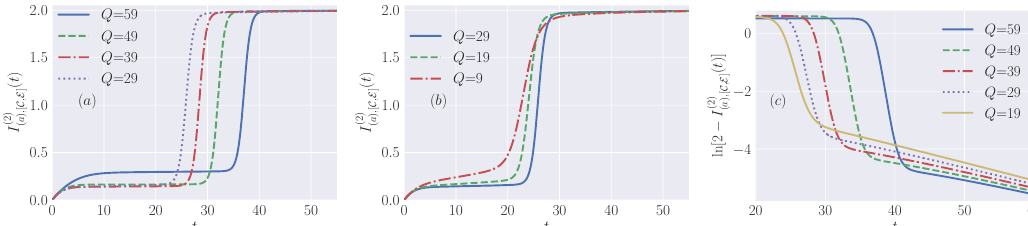
Figure 11 . Mutual information I (2) ( t ) [de(cid:12)ned in eq. (4.2)] for the setting displayed in (cid:12)g- ( a ) ; [ C ; E ] ure 8( a ). Sub(cid:12)gures ( a ) and ( b ) correspond to the initial state (4.6) for di(cid:11)erent values of the initial charge Q = N 1 n , respectively larger and smaller than N= 2. Sub(cid:12)gure ( c ) shows (cid:0) (cid:0) h i ln 2 I (2) ( t ) for the same state (and di(cid:11)erent values of Q ) at late times. For all plots, the ( a ) ; [ C ; E ] (cid:0) evolution is driven by the RUC with a conserved U(1) charge de(cid:12)ned in section 3.2, where we set (cid:21) 1 = 1, (cid:21) 2 = 2 and N = 60 (while we chose d = 2).